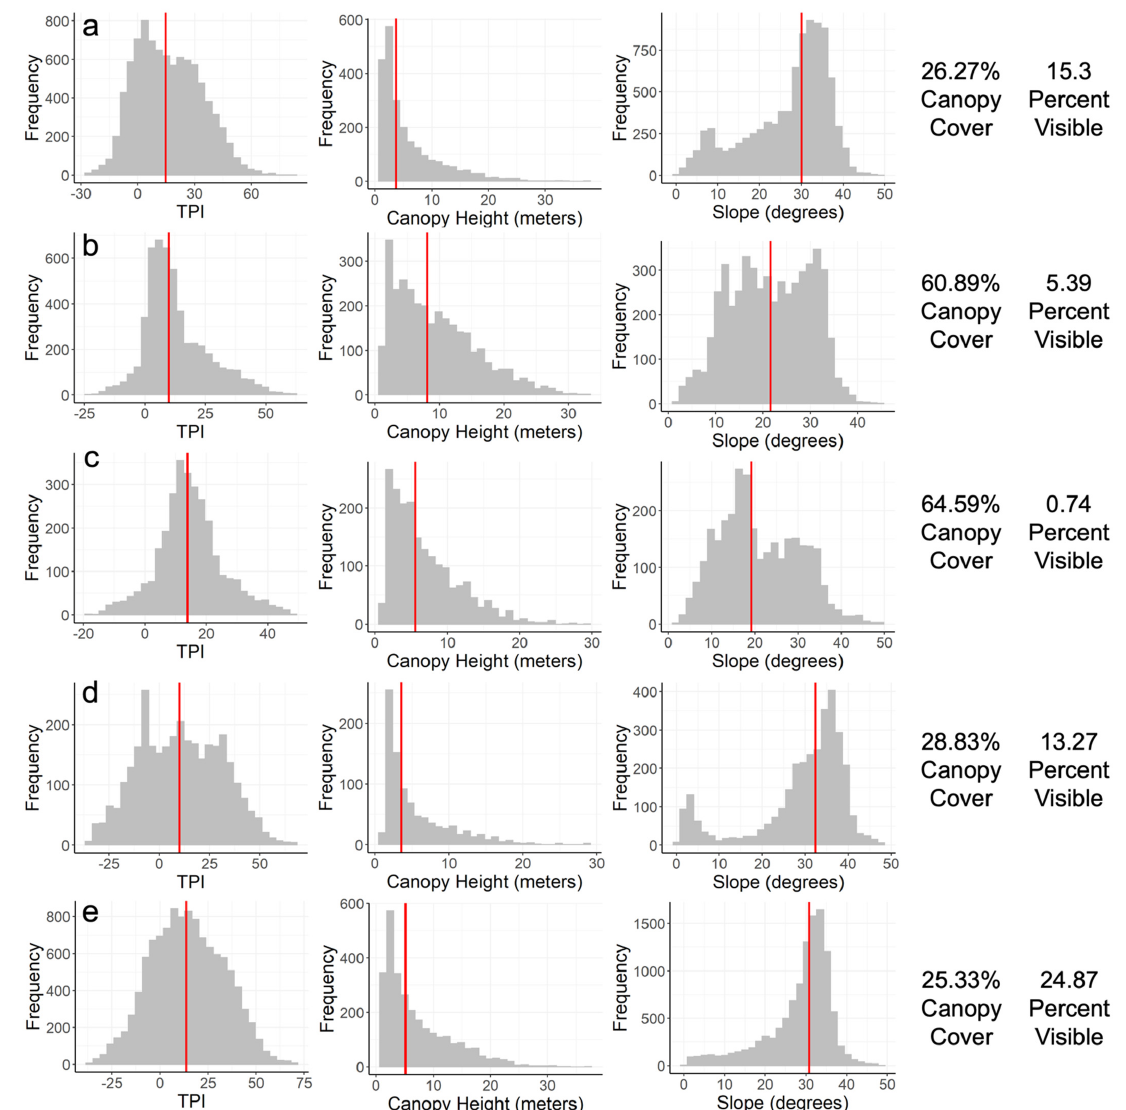
Figure 9. Distributions of handline metrics where frequency ( y -axis) refers to the number of occurrences of each variable ( x -axis) in the designated buffer zone. Percent visible was derived from non-thresholded viewsheds processed using 5 m, lidar-derived DSMs, where percent visible = 𝑉𝐼 (cid:3400) 100 . (Row ( a )) 2021-07-21. (Row ( b )) 2021-07-22. (Row ( c )) 2021-07-23. (Row ( d )) 2021-07-25. (Row e ) 2021-08-05.